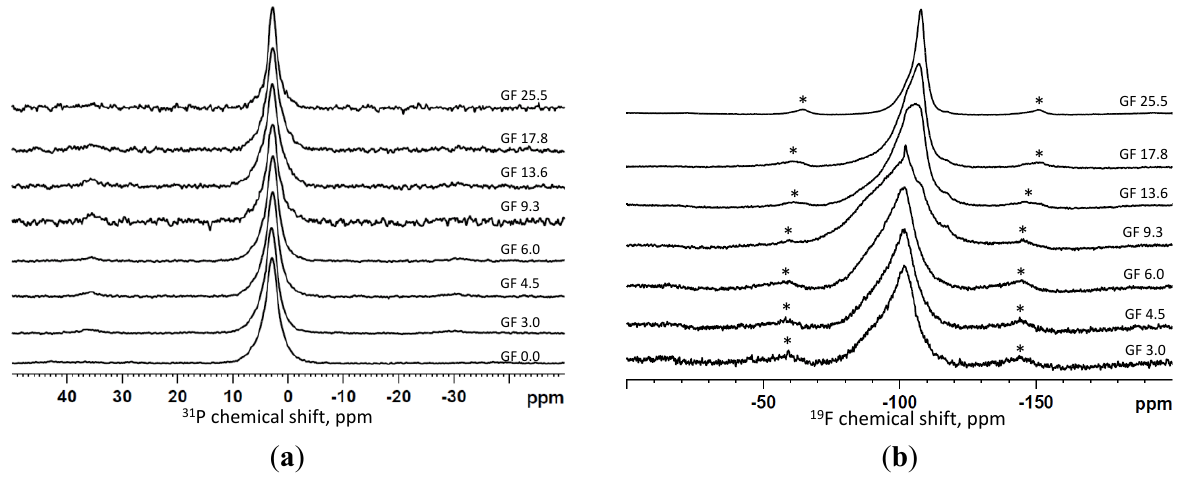
Figure 3. 31 P ( a ) and 19 F ( b ) MAS-NMR spectra of the samples collected after immersion in Tris buffer solution for 6